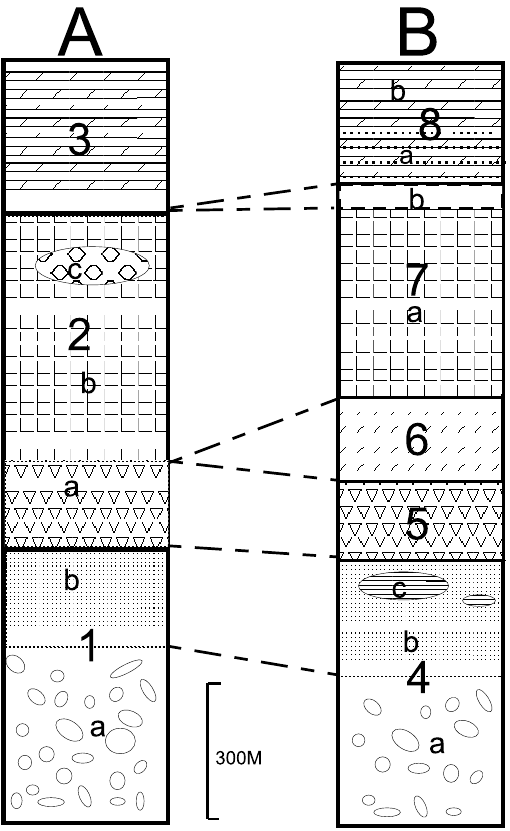
Fig. 2 – Comparison between the stratigraphic columns of the CampoAlegre Basin proposed by Ebert (1971) –A, and by Daitx and Carvalho (1981) – B. Units: A: 1 – Bateias Formation, a